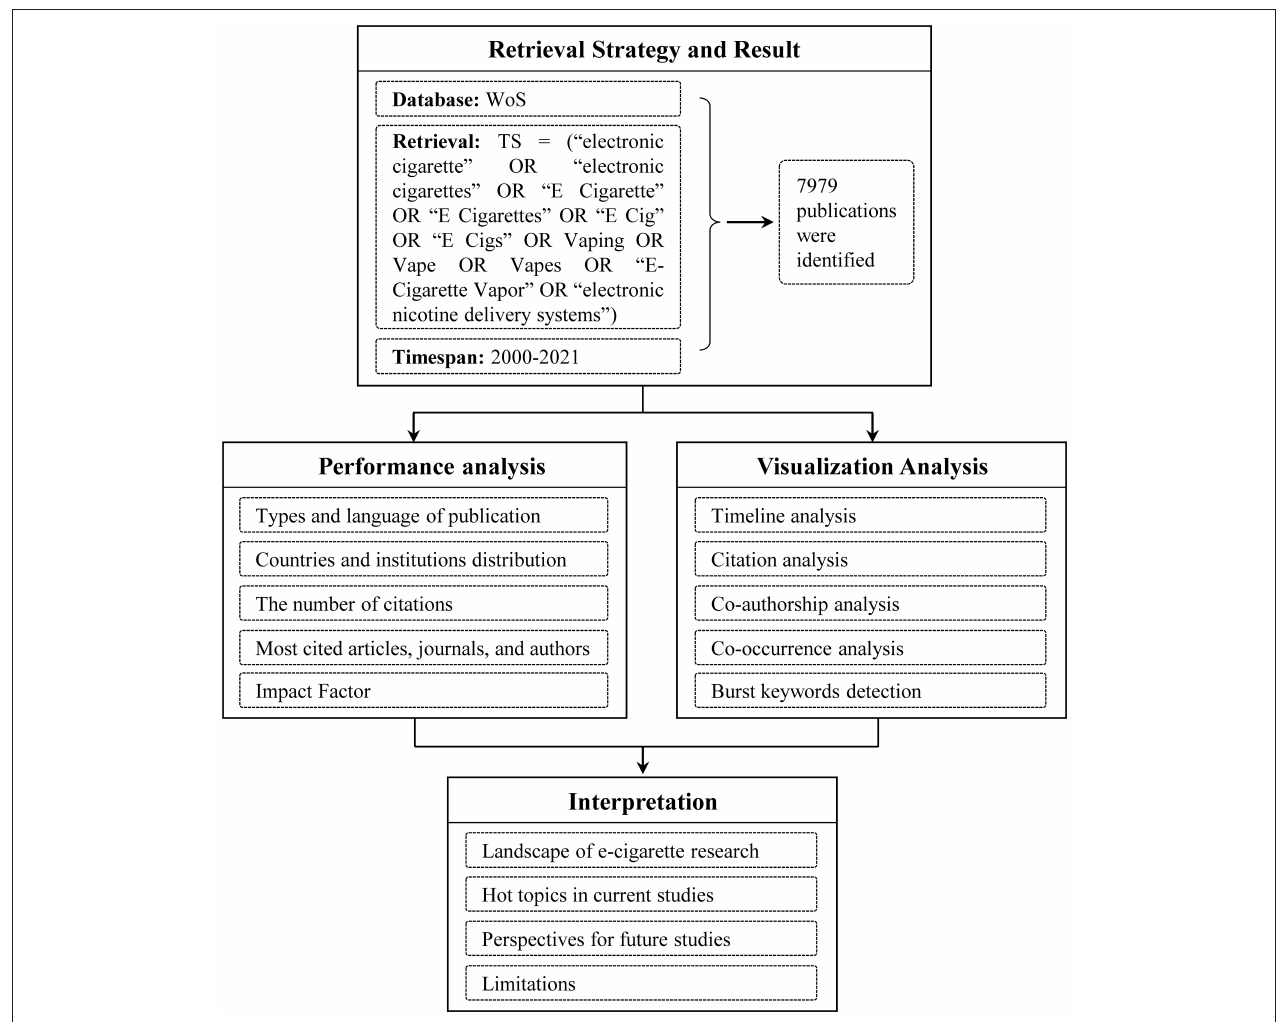
FIGURE 1 | The flowchart of the research framework in this study.